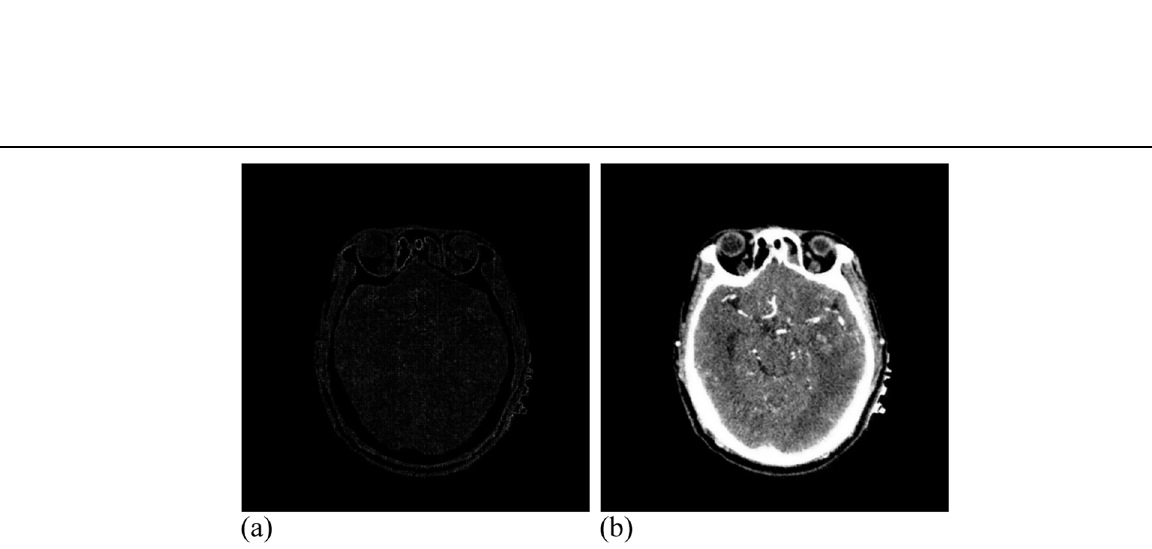
Fig. 20 CT data after registration. (a) : Difference between CT reference image and registration image; ( b ): CT registration